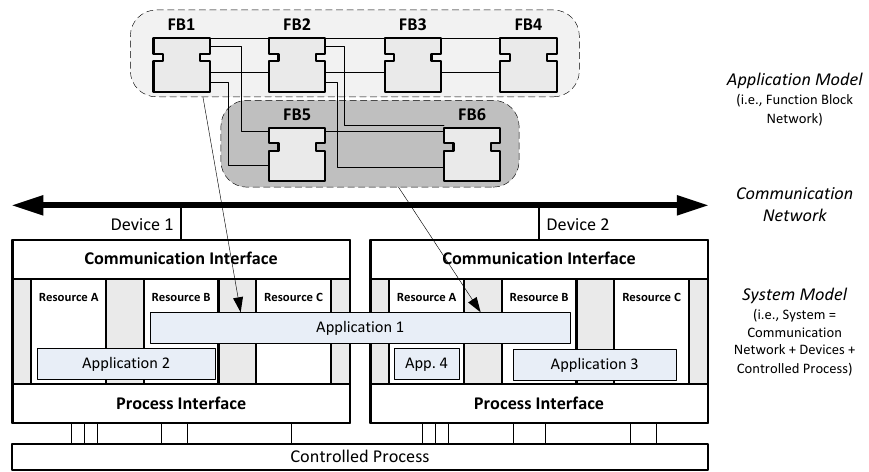
Figure 2. IEC 61499 reference models for distributed automation, based on